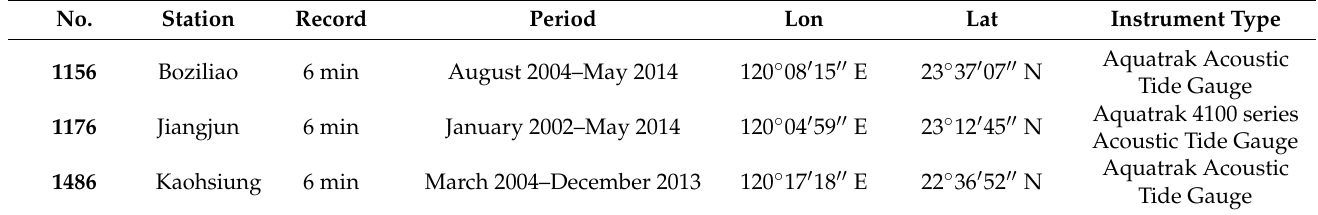
Table 2. Information of tide-gauge